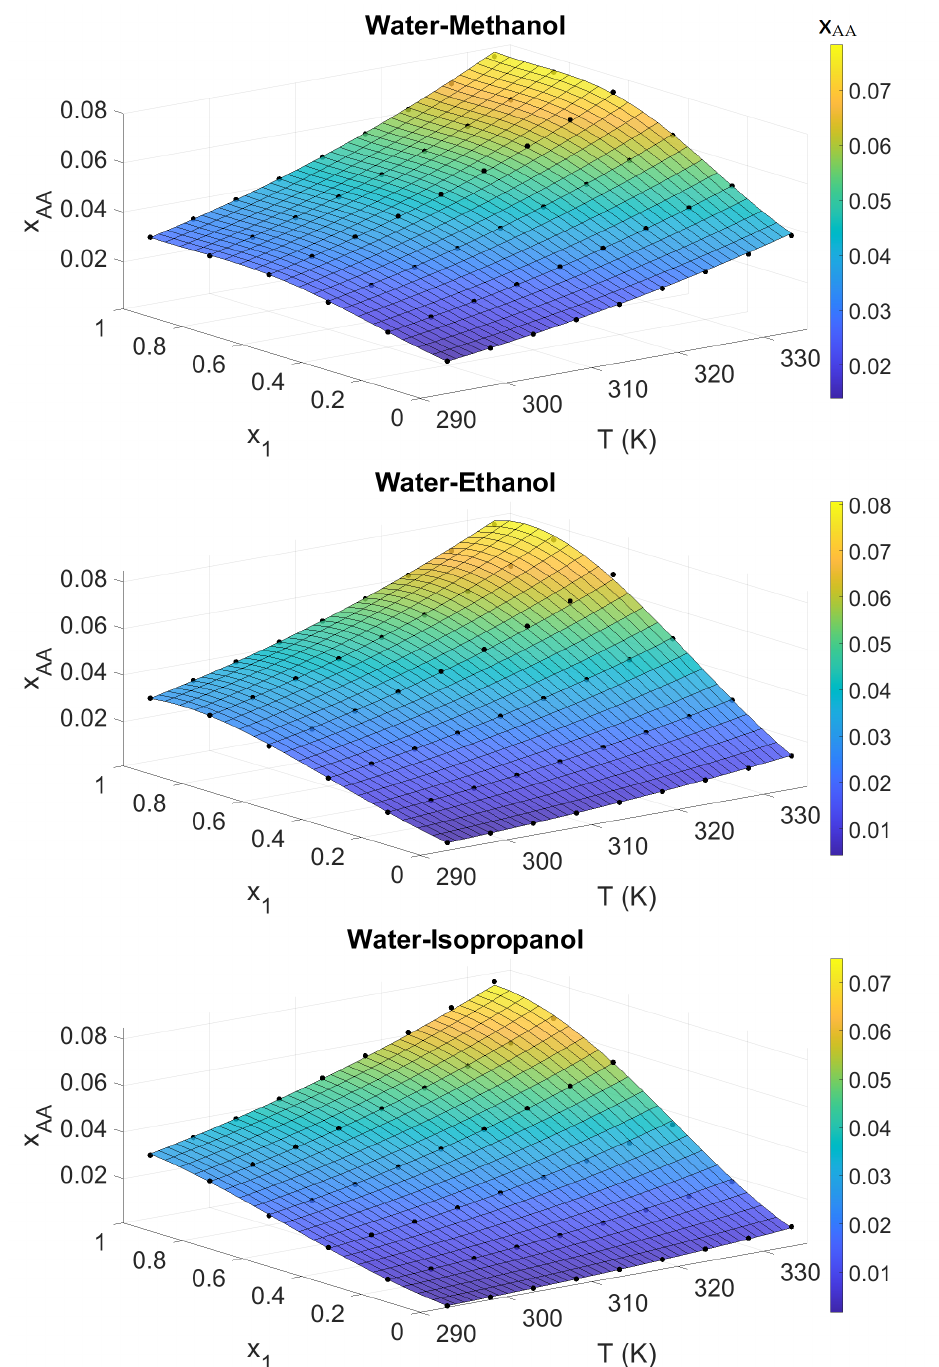
Figure 5. Surface plot of solubility versus solvent composition and temperature using the Jouyban- Acree model for three water-alcohol systems. The symbols represent the experimental